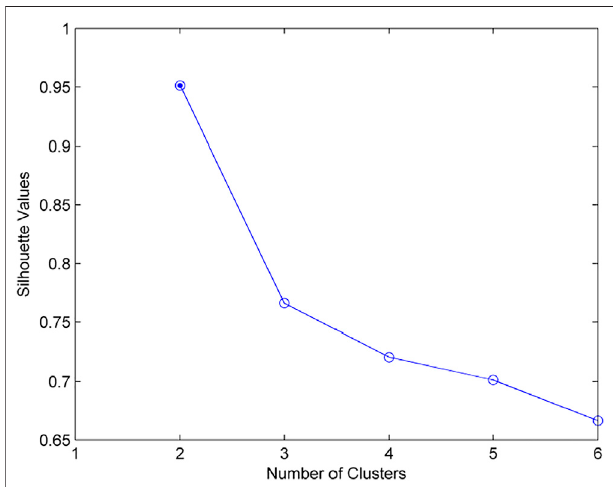
FIGURE 5 | The optimal k number considered based on silhouette